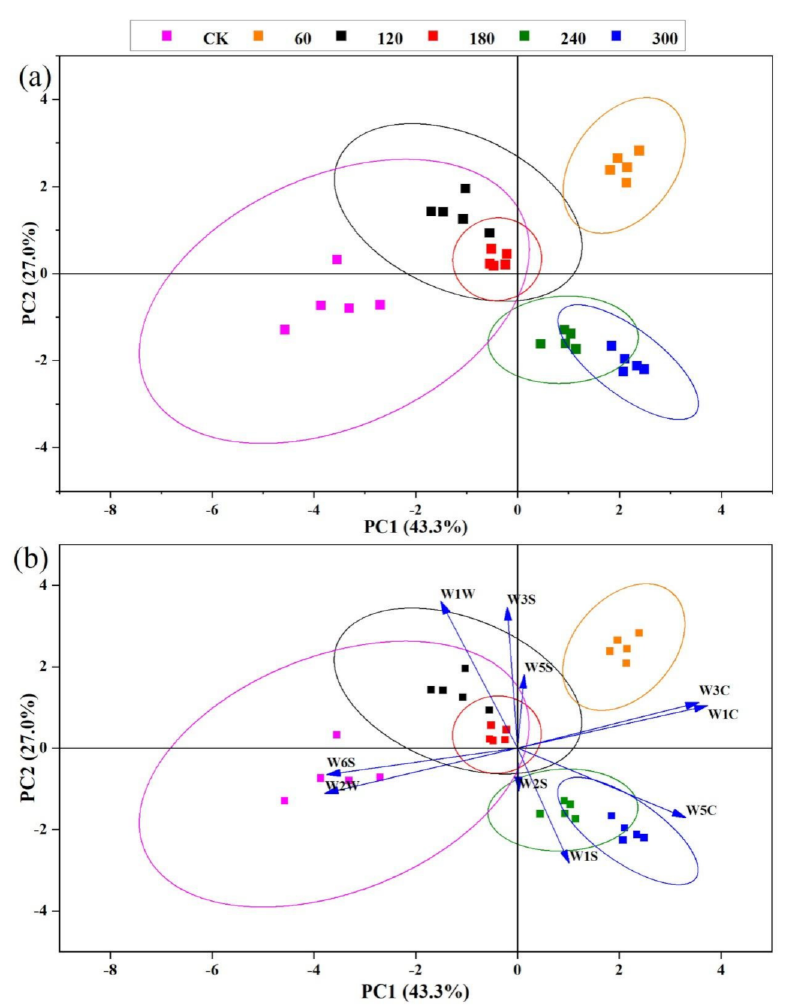
Figure 1. ( a ) PCA plot describing the variation in the odour fingerprints of HVCP treated EWP; ( b ) Loading plot describing the distribution of odour fingerprints across various HVCP treatments on the EWP; CK: Control; PC1: Principal component 1; PC2: Principal component 2; W1C: Aromatic compounds; W5S: Ammonia and aromatic molecules; W3C: Broad-nitrogen oxide; W6S: